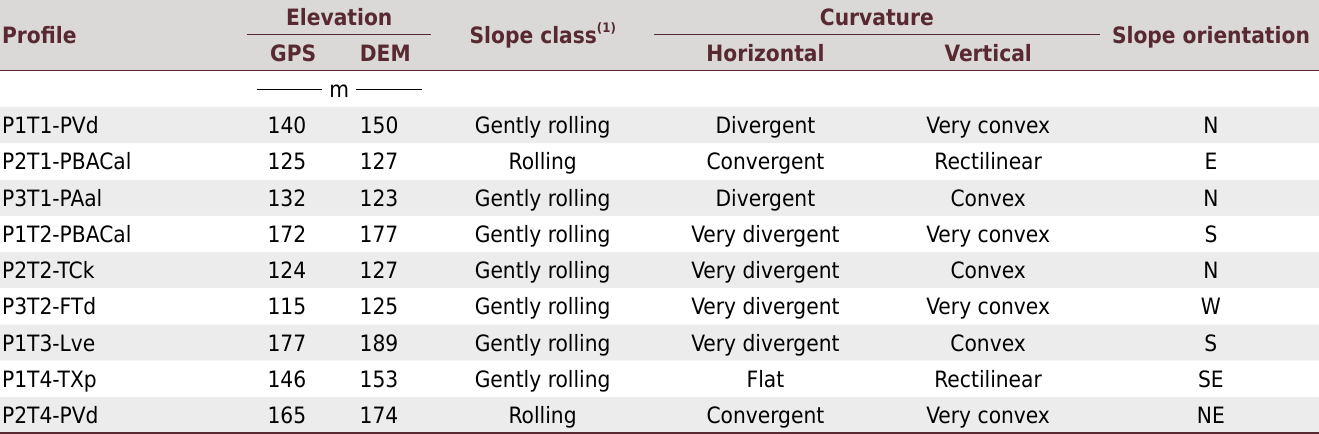
Table 4. Altimetric variables and geomorphometric derivations